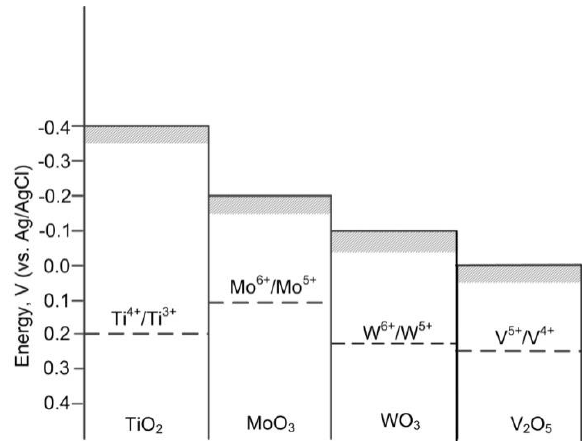
Figure 11. Schematic energy diagram of TiO 2 /MoO 3 , TiO 2 /WO 3 , and TiO 2 /V 2 O 5 photocatalysts.